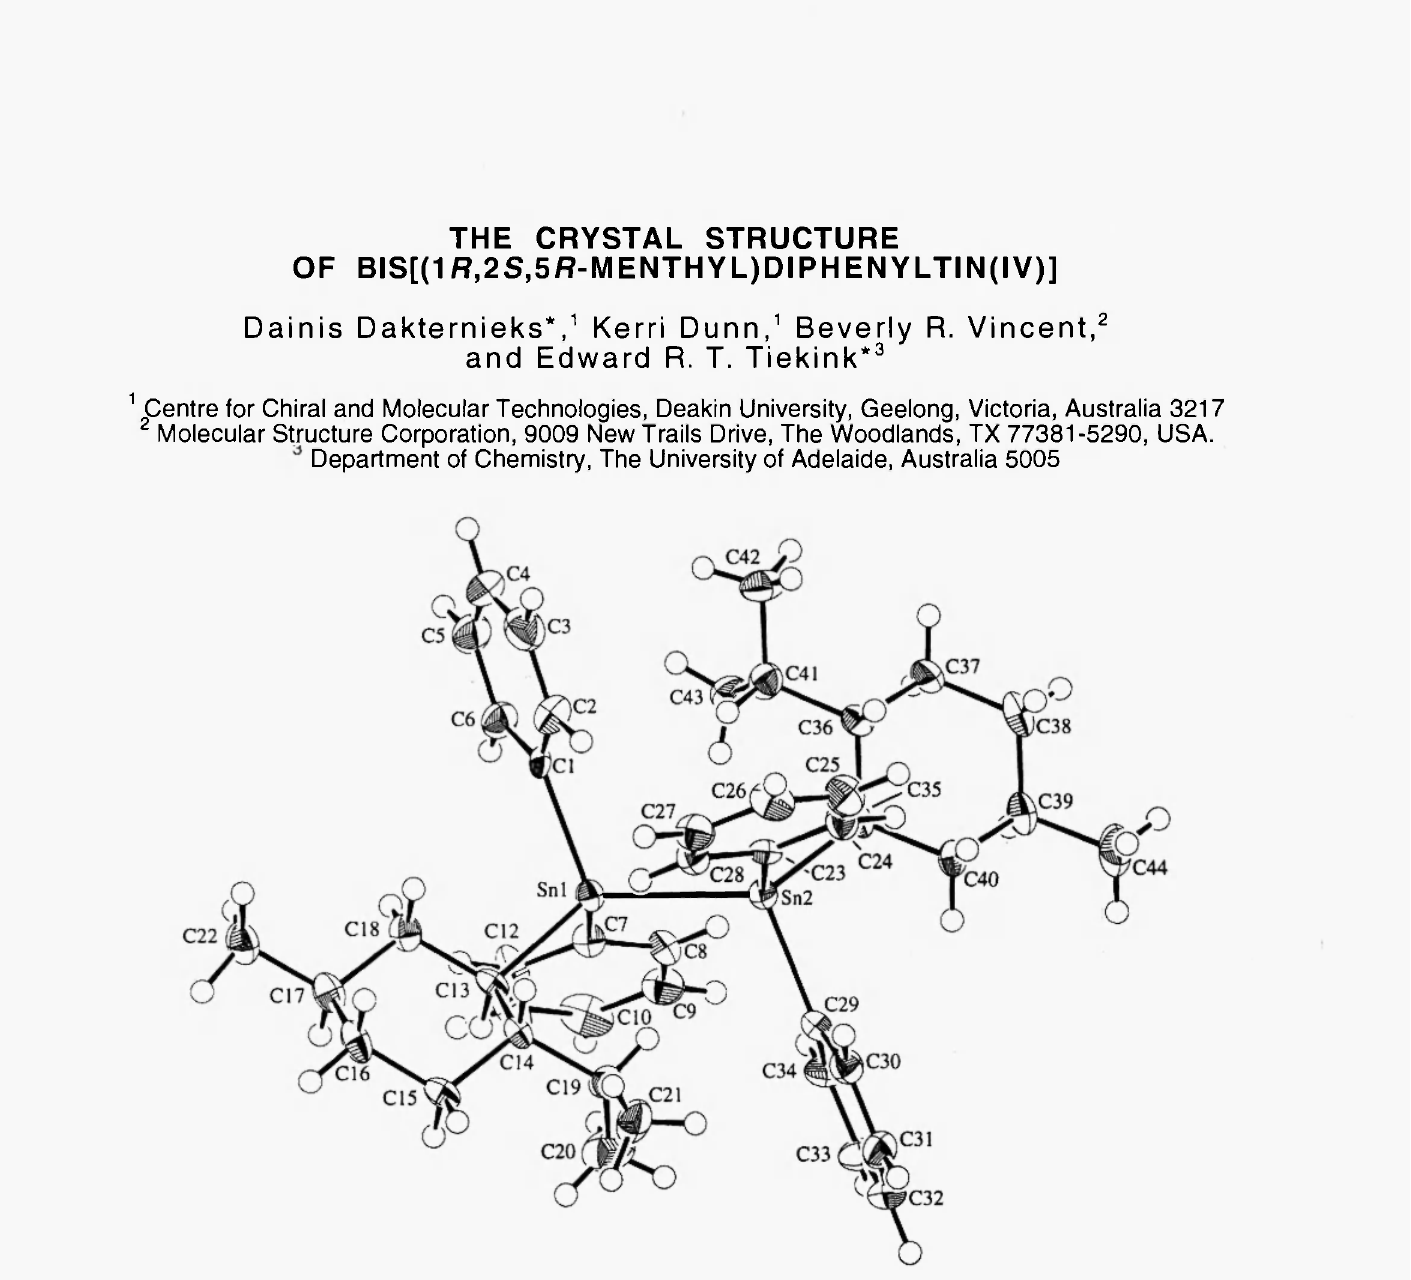
Figure 1. Molecular structure (50% probability ellipsoids) of [MenPh 2 Sn] 2 . Selected bond distances and angles: Sn(1)-Sn(2) 2.8064(5), Sn(1)-C(1) 2.169(6), Sn(1)-C(7) 2.169(5), Sn(1)- C(13) 2.203(5), Sn(2)-C(23) 2.157(5), Sn(2)-C(29) 2.172(6), Sn(2)-C(35) 2.193(5) Ä; Sn(2)-Sn(1)-